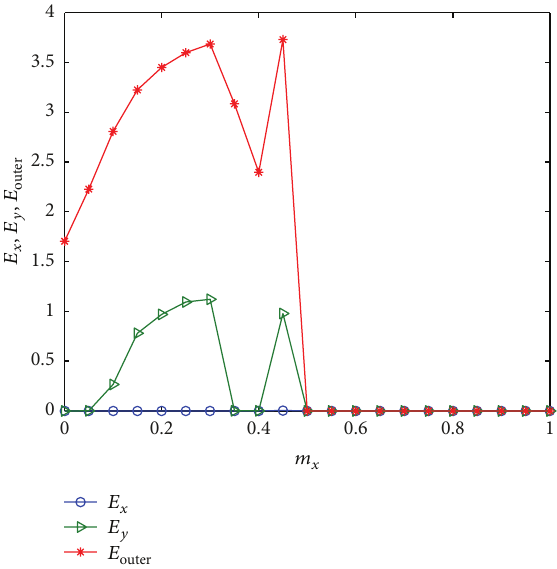
at 𝑡 = 400 with outer